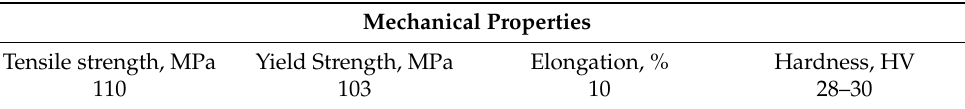
Table 2. Mechanical properties of AA1050-H14 Al alloy.